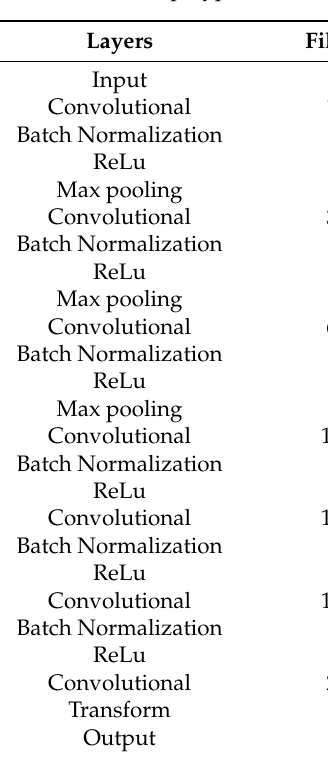
Figure 9. Colorectal polyp detection system architecture. Table 3. Colorectal polyp detection model